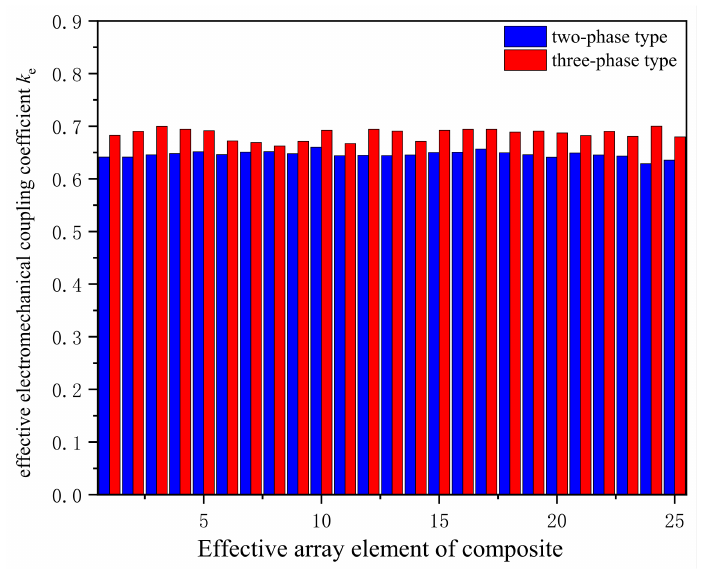
Figure 11. Effective electromechanical coupling coefficients of two 1–3 piezoelectric